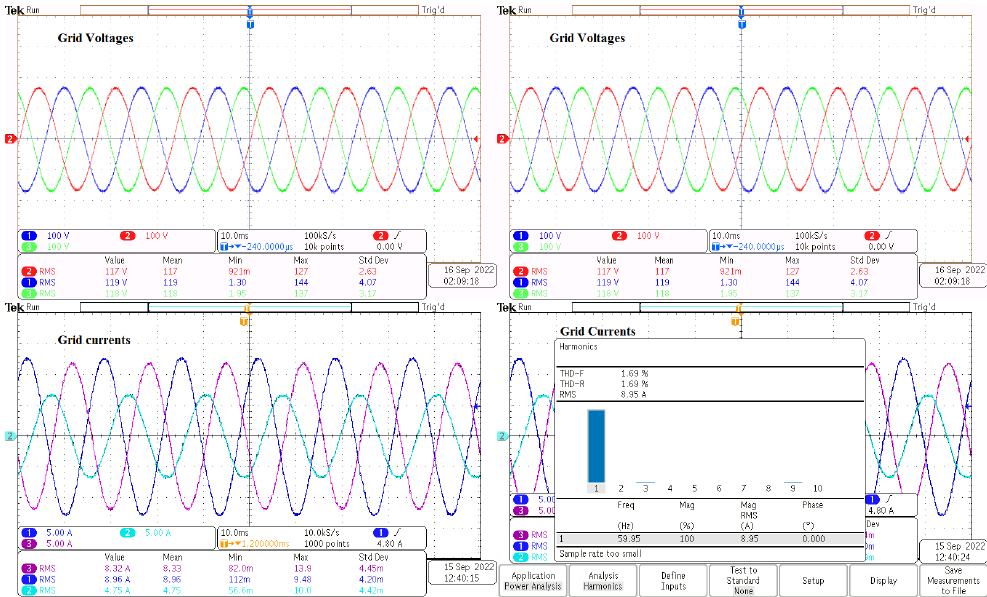
Figure 25. Experimental results before applying the proposed method under unbalanced grid inductances.